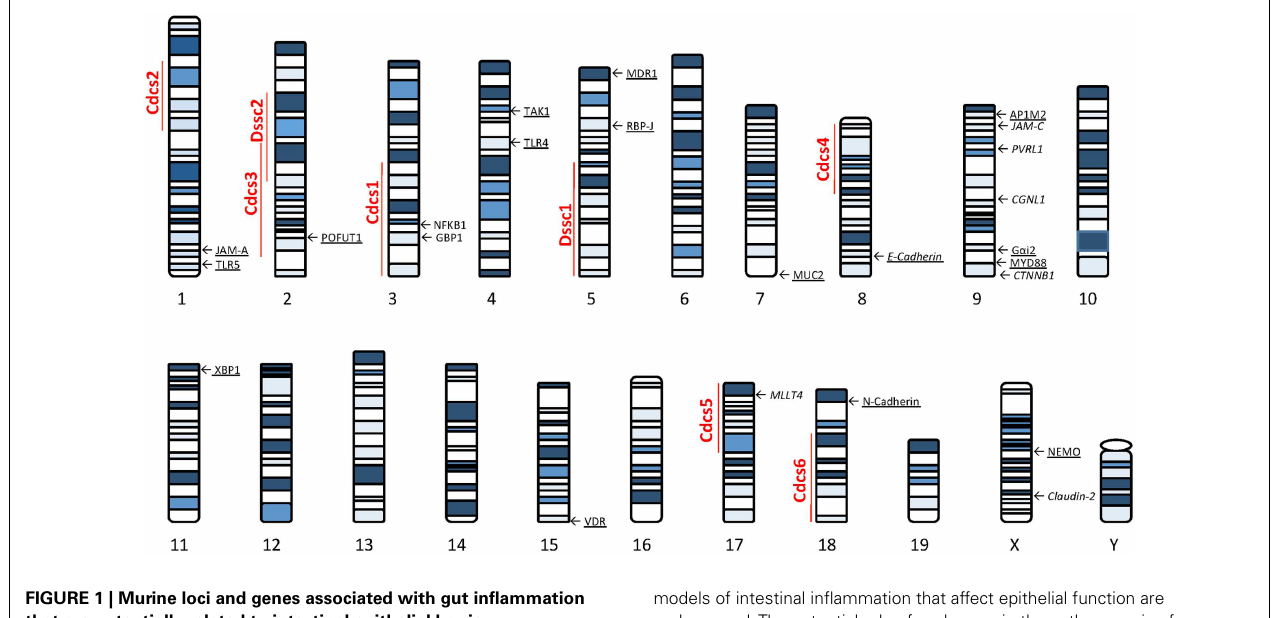
FIGURE 1 | Murine loci and genes associated with gut inflammation that are potentially related to intestinal epithelial barrier dysfunction . Colitis susceptibility loci, Cdcs, and Dssc, are identified by red bold font. Genes potentially involved in the epithelial barrier defect characteristic of SAMP mice are italicized. Genes deleted in mouse